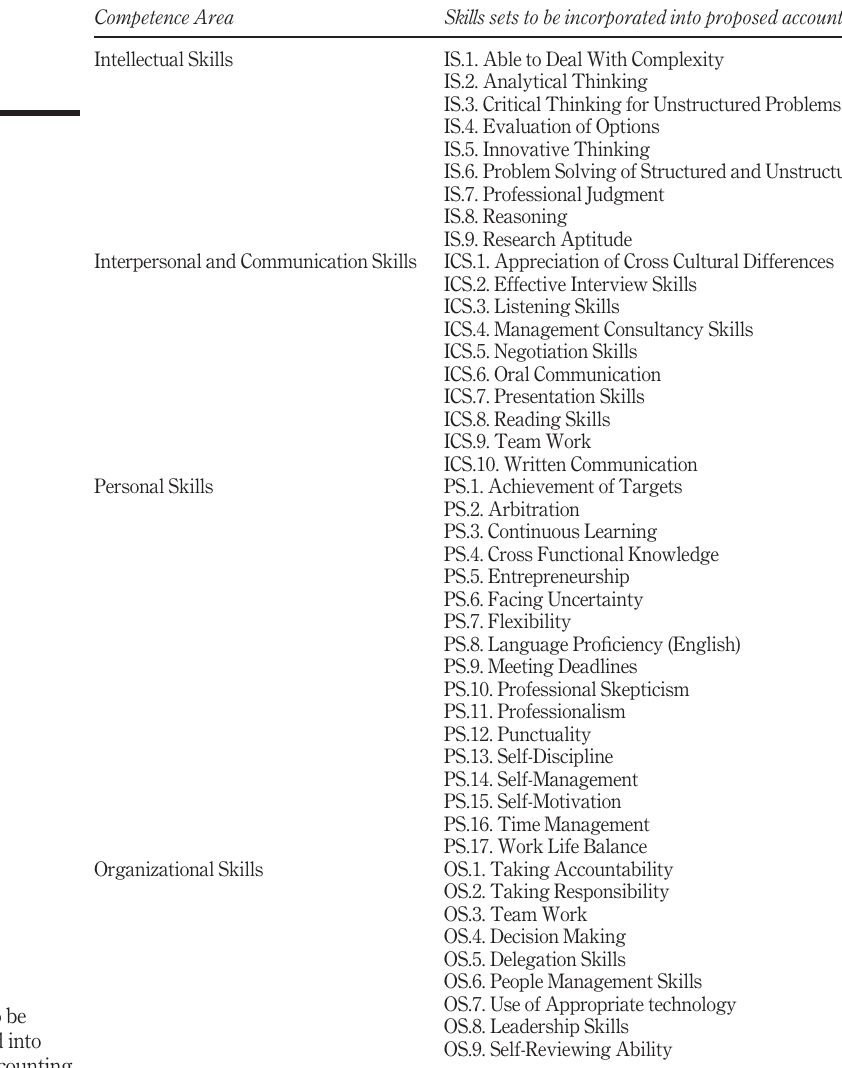
Table A1. Skills sets to be incorporated into proposed accounting education – Part